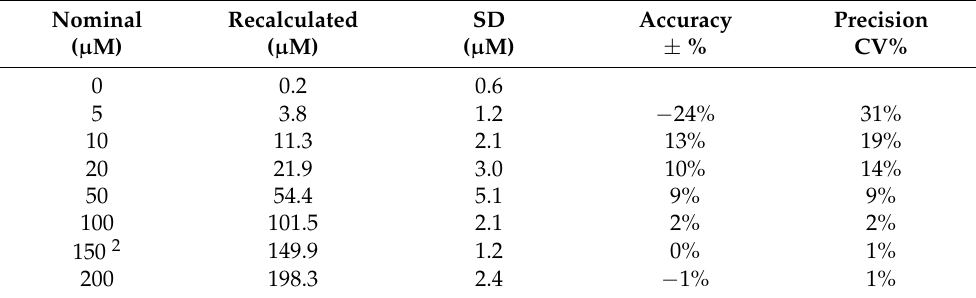
Table 1. The accuracy and precision of the nitrite measurement 1